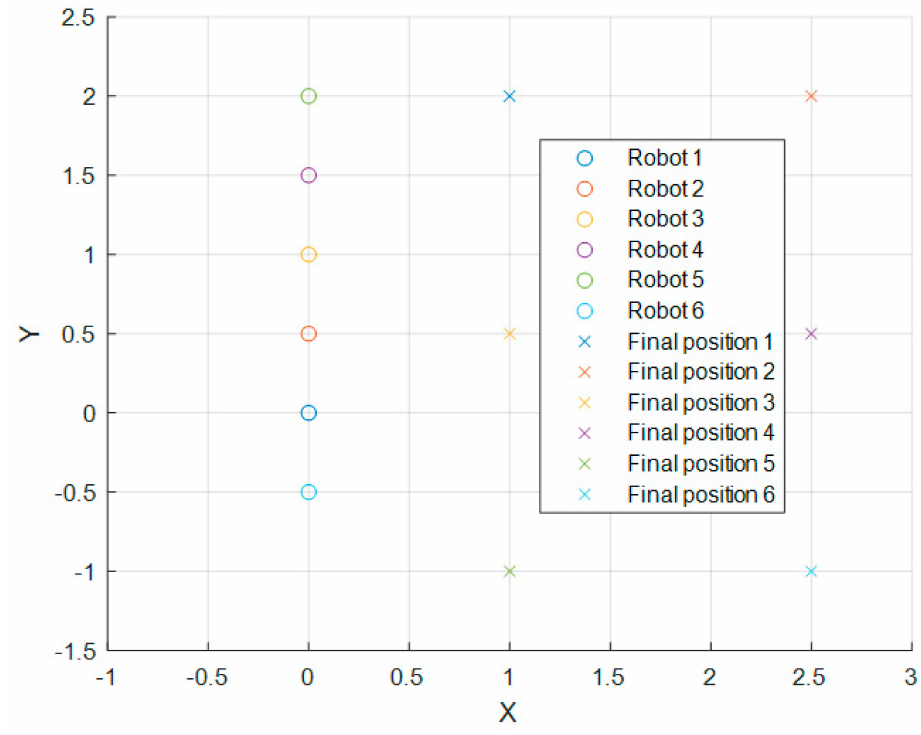
Figure 5. Initial positions of the 6-robot experiment and the desired objective for each